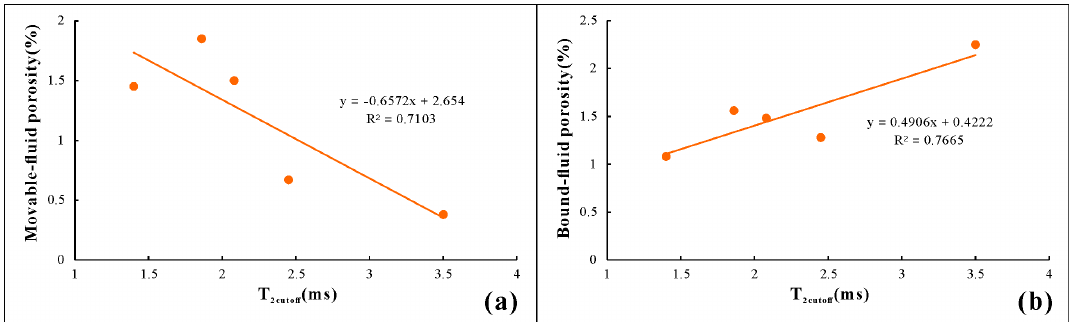
Figure 12. The correlations between movable-fluid porosity, bound-fluid porosity and T 2cutoff . ( a ) the correlation between T 2cutoff with movable-fluid porosity; ( b ) the correlation between T 2cutoff with bound-fluid porosity.